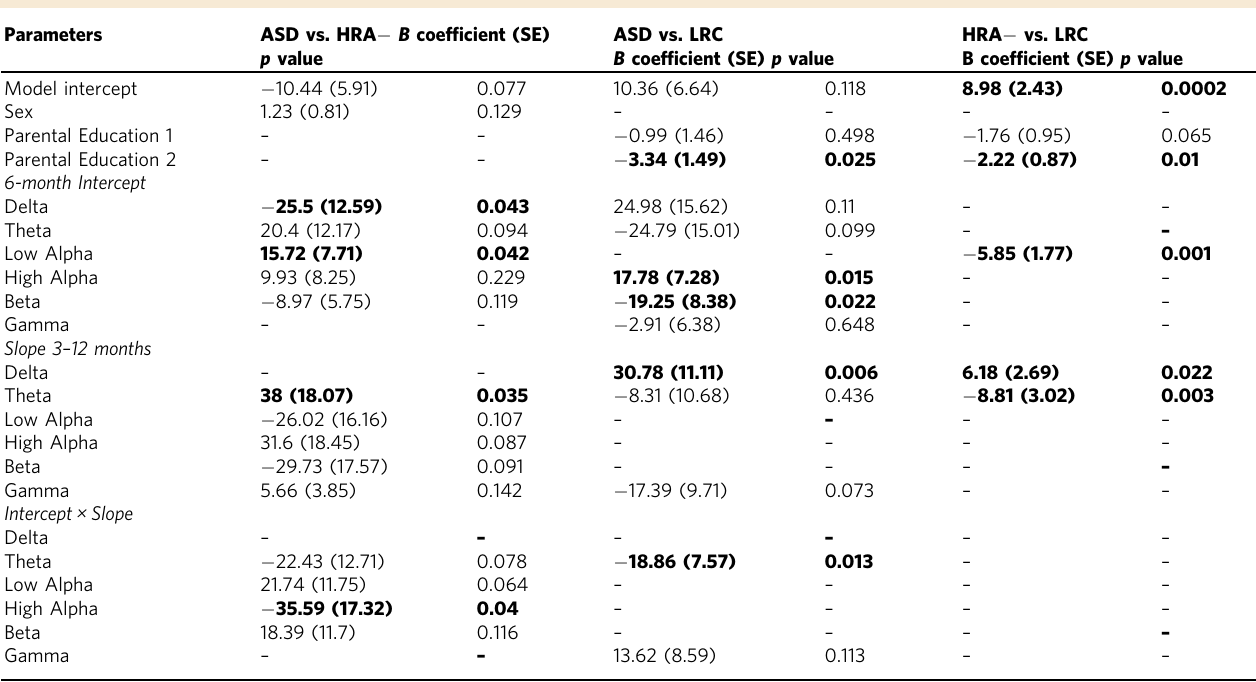
Table 2 Frontal 3 – 12 months EEG power models